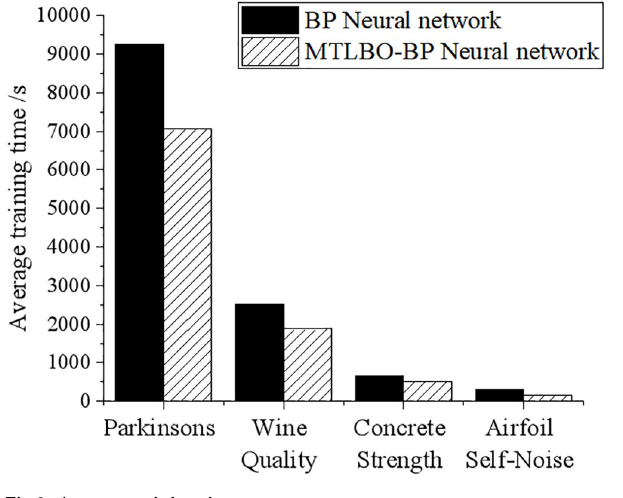
Fig 8. Average training